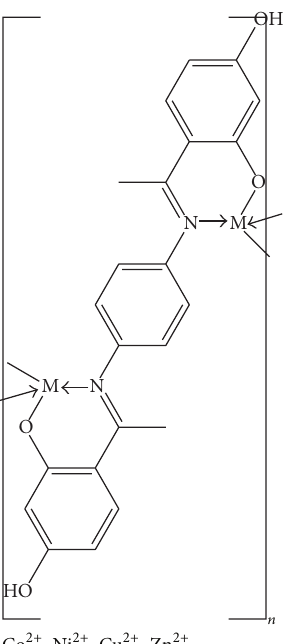
Figure 1: Structure of the polymeric